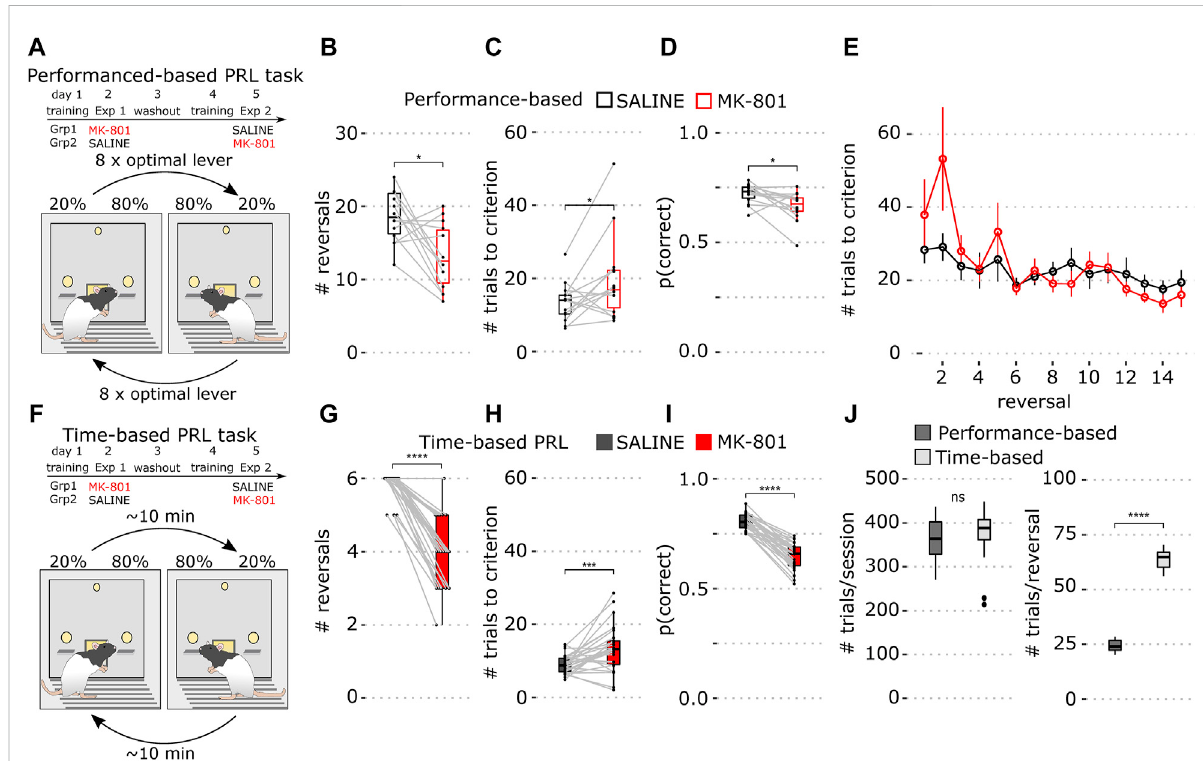
FIGURE 1 Performance- and time-based reversal tasks. (A) Schematics of theexperiment and the performance-based PRL task schedule where reversals are triggered by 8 responses on the optimal lever. (B) Number of completed reversals in vehicle (black) and MK-801 (red) in the performance-based PRL. (C) Meannumberoftrialsto criterionoverall reversals intheperformance-based PRL. (D) Proportioncorrectresponsesoverthewhole60-min session (E) Number of trials to criterion for individual reversals. Data show mean ± SEM. (F) Schematic of the time-based PRL task schedule where reversals occur on an average every 10 min. (G) Number of completed reversals determined with a performance criterion ( > 8 consecutive correct responses) in the time-based PRL. (H) Mean number of trials to criterion across all reversals in the time-based PRL. (I) Average proportion